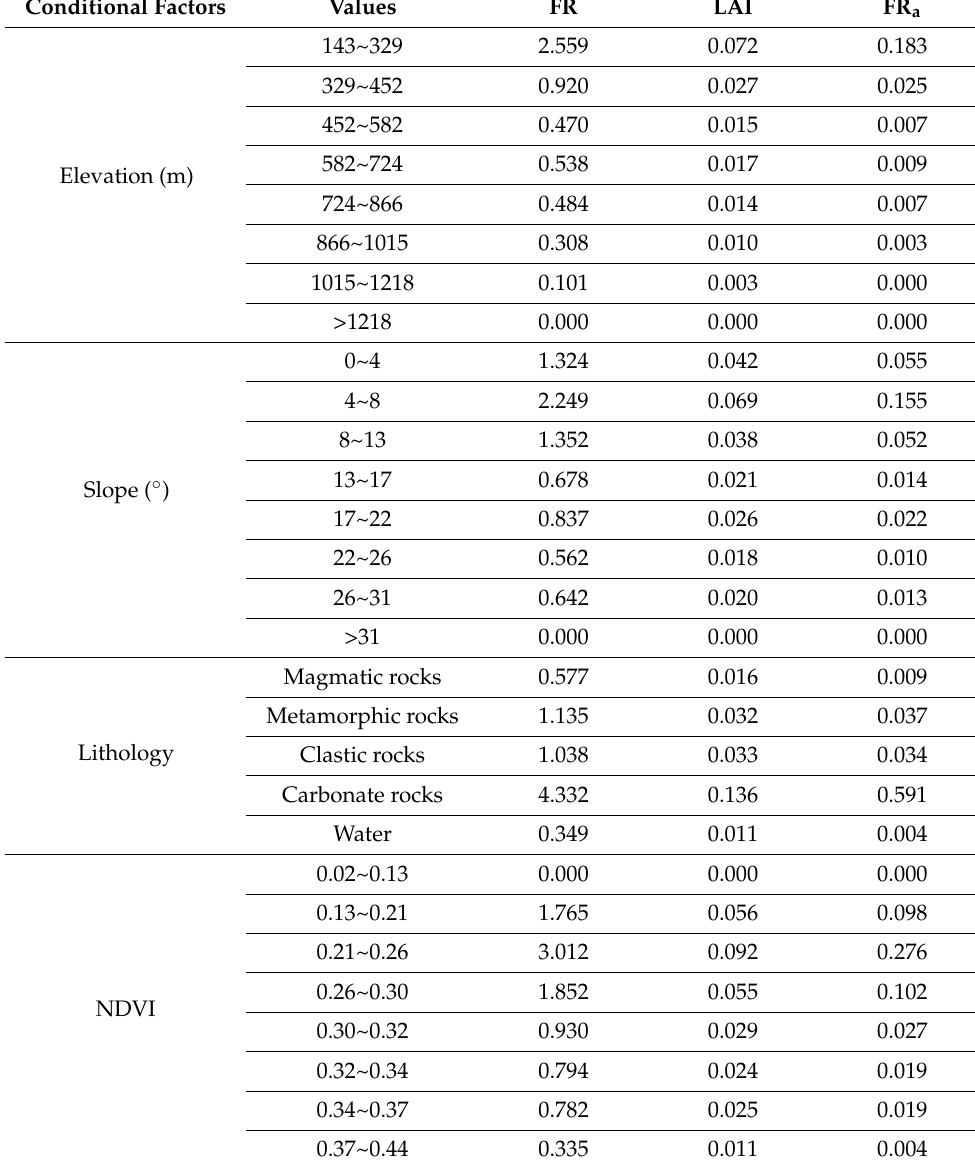
Table 1. FR values considering landslide spatial aggregation (some factors are not shown). Conditional Factors